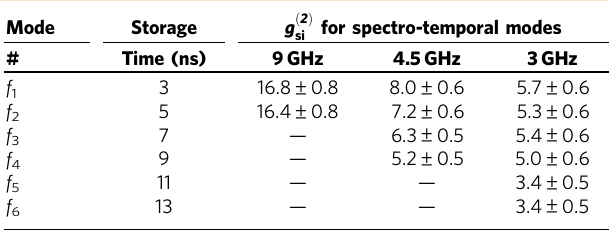
Table 1 | Experimental cross-correlation values. Mode